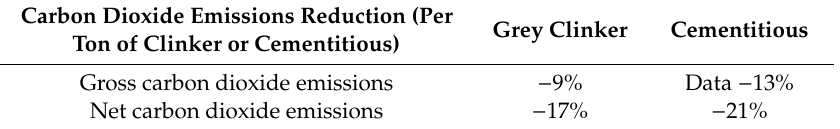
Table 1. Objectives to decrease the carbon dioxide emissions in the European cement industry [5].